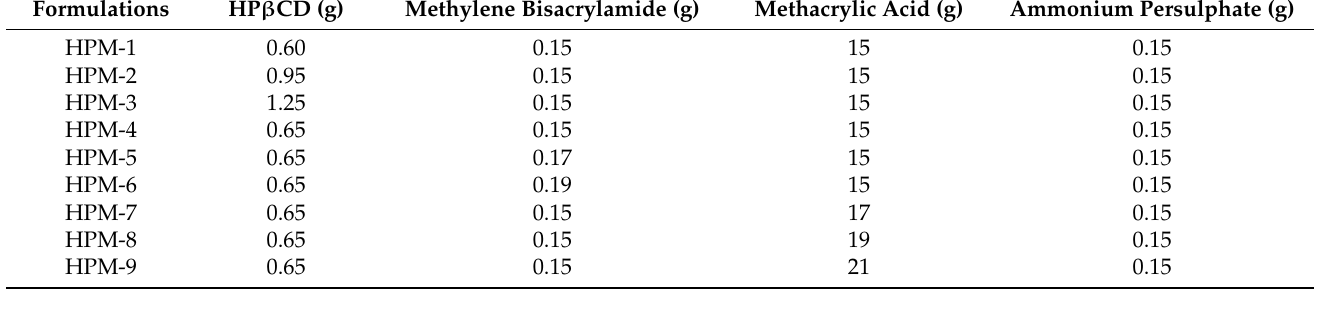
Table 6. Composition of HP β CD-grafted-poly (MAA) hydrogels (HPM-1 to HPM-9).